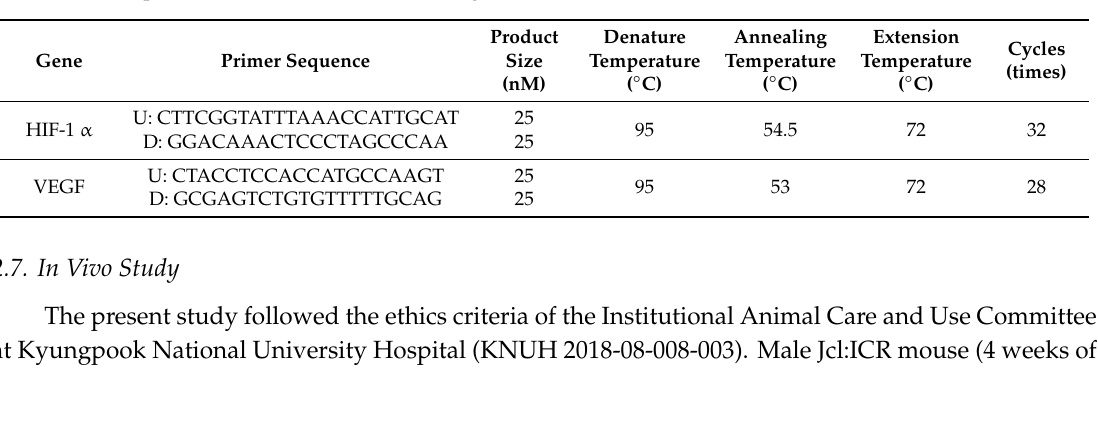
Table 1. Primers and cycling conditions for reverse transcription PCR. HIF- 1 α : Hypoxia-inducible factor 1-alpha; VEGF: vascular endothelial growth